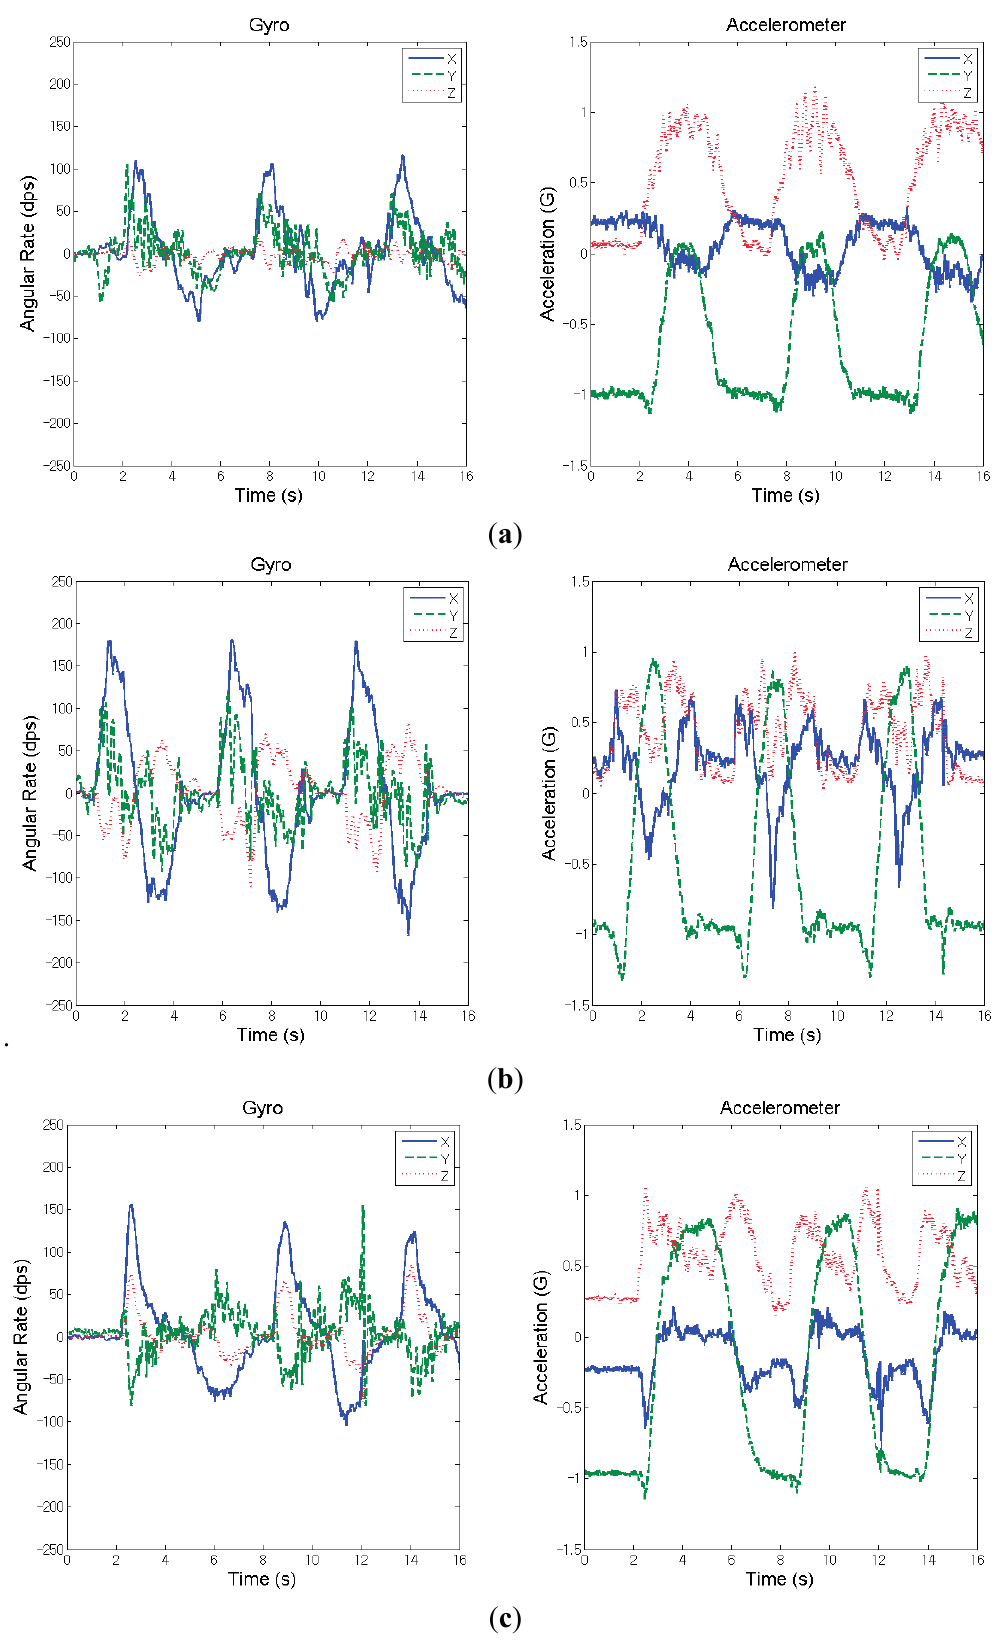
Figure 4. Measured inertial signals from the wrist of a stroke patient during the movement of shoulder flexion (three cycles). ( a ) Affected side (before treatment); ( b ) affected side (after treatment); and ( c ) unaffected